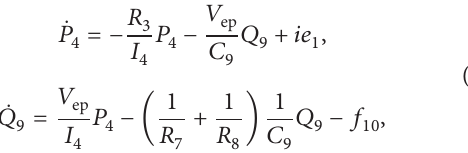
Figure 4: Bond graph model of the emulsion pump.